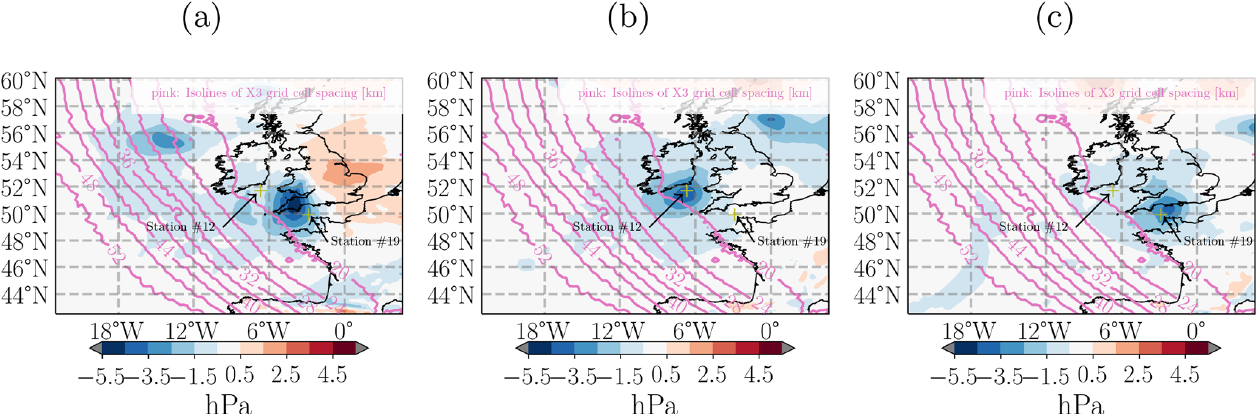
Figure 8. Difference of sea level pressure between X3-CPKF and X1-CPKF at (a) 28 October 2013, 06:00UTC, (b) 28 October 2013, 18:00UTC and (c) 29 October 2013, 00:00UTC exemplifying the propagation of the small low pressure system from the North Atlantic towards south-east. Station #12 and #19 as well as the mesh transition zone of the X3 mesh configuration are depicted for